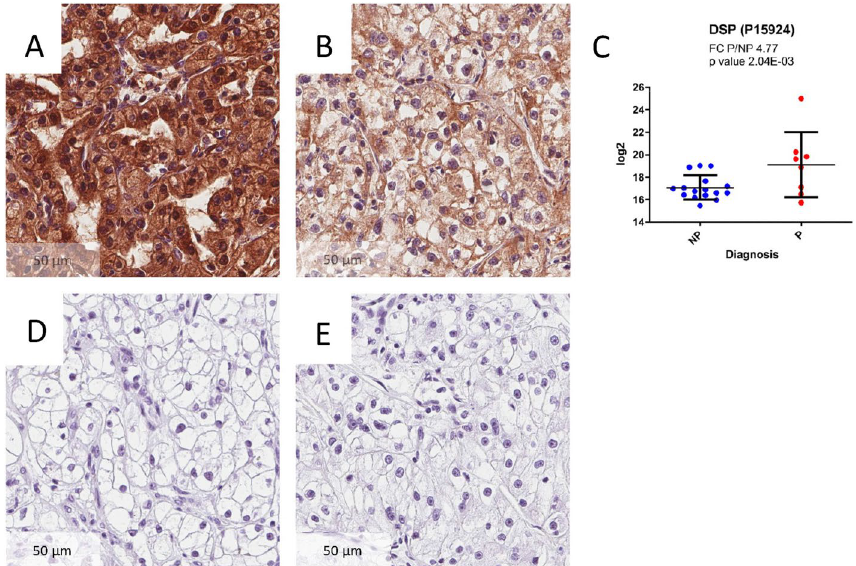
Figure 5. Immunohistochemistry (IHC) of Desmoplakin (DSP) and its protein abundance plot. DSP was expressed to a higher extend in P ( A ), compared to NP ( B ) tumors based on both proteomics data and IHC results. IHC results (40 ×) are from a matched sample pair. The image was taken from the most markedly stained sections of each slide. ( C ) depicts the log2 abundance values of DSP in the proteomics dataset. ( D ) Depicts the staining without the primary antibody. ( E ) Depicts the staining without the secondary